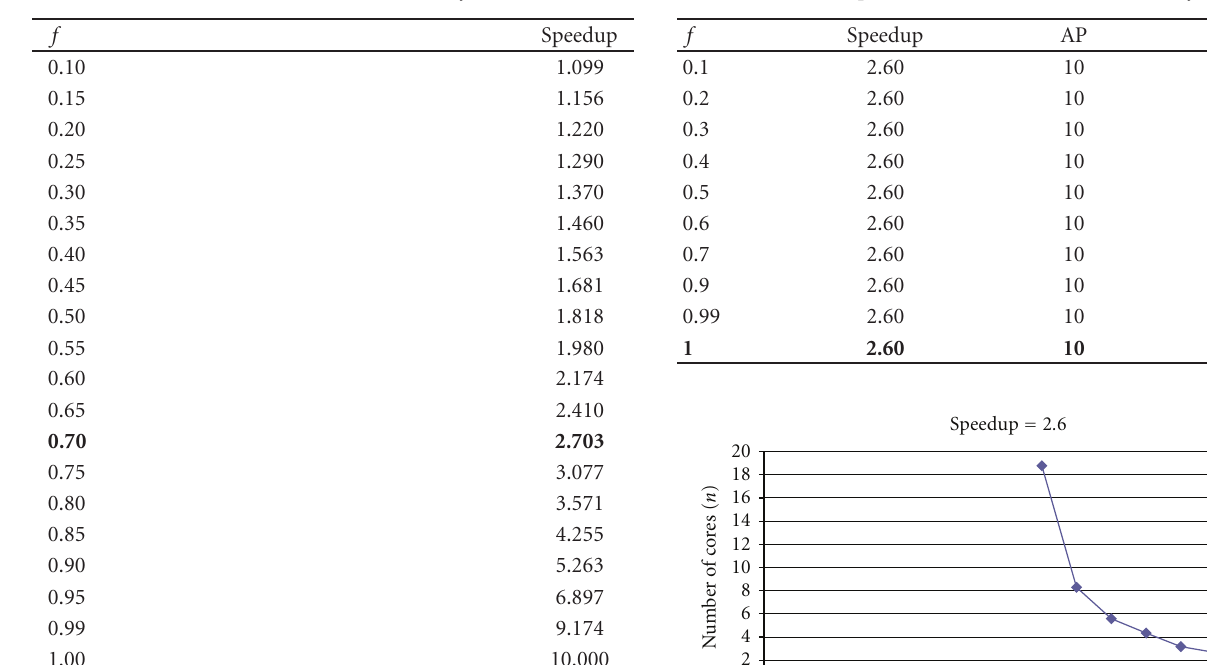
Table 1: Acceleration as a function of f , n = 10. Table 2: Sequential acceleration as a function of f .